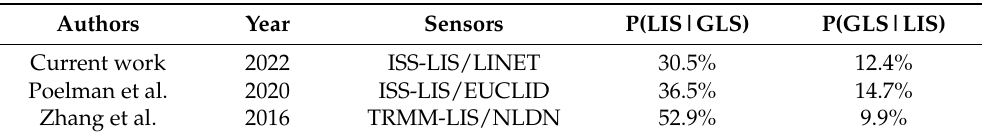
Table 1. Detection efficiencies of a ground lightning system (GLS) with respect to a satellite system and vice versa, calculated with the Bayesian approach, including results and correspondent values from the literature.